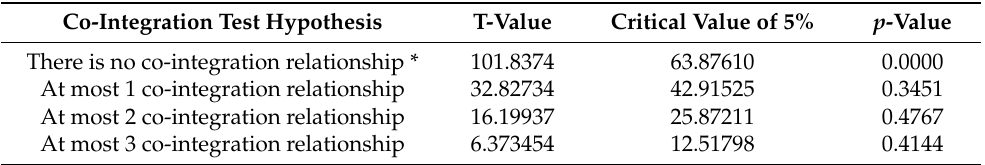
Table 7. Results of Johansen co-integration